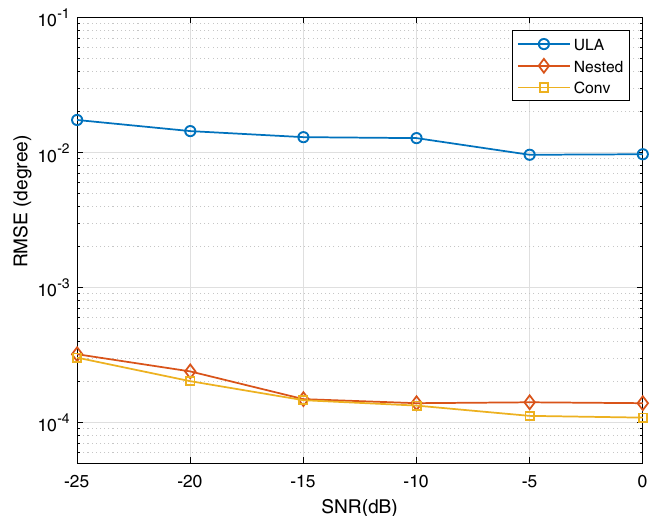
Fig. 6 MUSIC spectrum of the three arrays with closely spaced sources, SNR